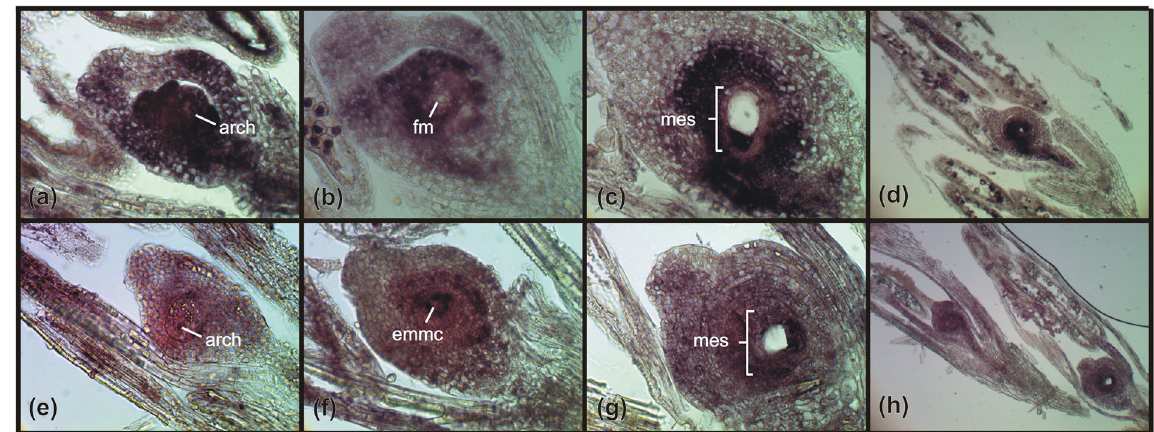
Figure 5. mRNA in situ hybridization of EcDMT102 during sexual and apomictic reproduction in E. curvula . ( a – d ) Ovaries from the sexual genotype hybridized with an EcDMT102 antisense probe showing strong signals in the nucellus and reproductive cells throughout development. ( a ) Young ovule primodium containing an archespore. ( b,c ) Ovules containing young and mature embryo sacs. ( d ) general view of reproductive organs. ( e–h ) Ovaries from the apomictic genotype hybridized with an EcDMT102 antisense probe showing weaker, but similarly distributed than in the sexual plants, signals. ( e ) Young ovule primodium containing an archespore. ( f ) Ovule containing an enlarged, unreduced MMC. ( g ) Ovules containing mature embryo sac. ( h ) General view of reproductive organs. arch: archespore, dm: degenerated megaspores, fm: functional megaspore, mes: mature embryo sac, emmc: elongated megaspore mother